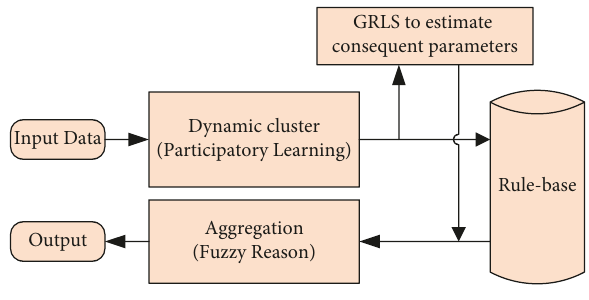
Figure 4: The general flowchart of ePL.